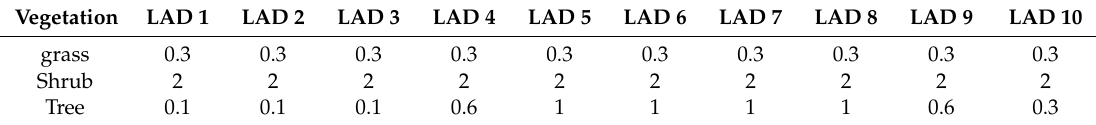
Table 4. Values of LAD (m 2 /m 3 ) for the different types of vegetation used in ENVI-met simulations.